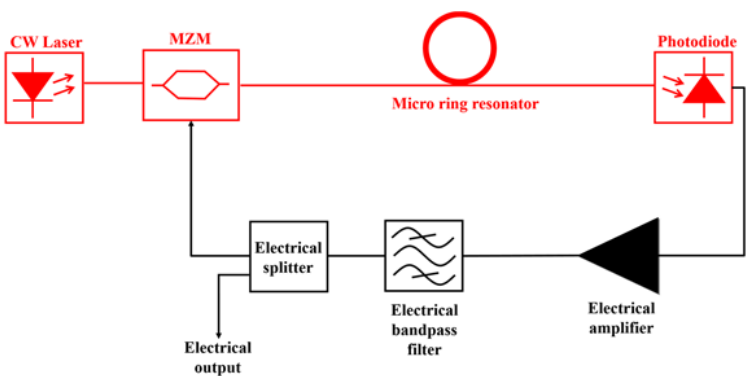
Figure 8. Simple configuration of an OEO with a micro-ring resonator (MRR).